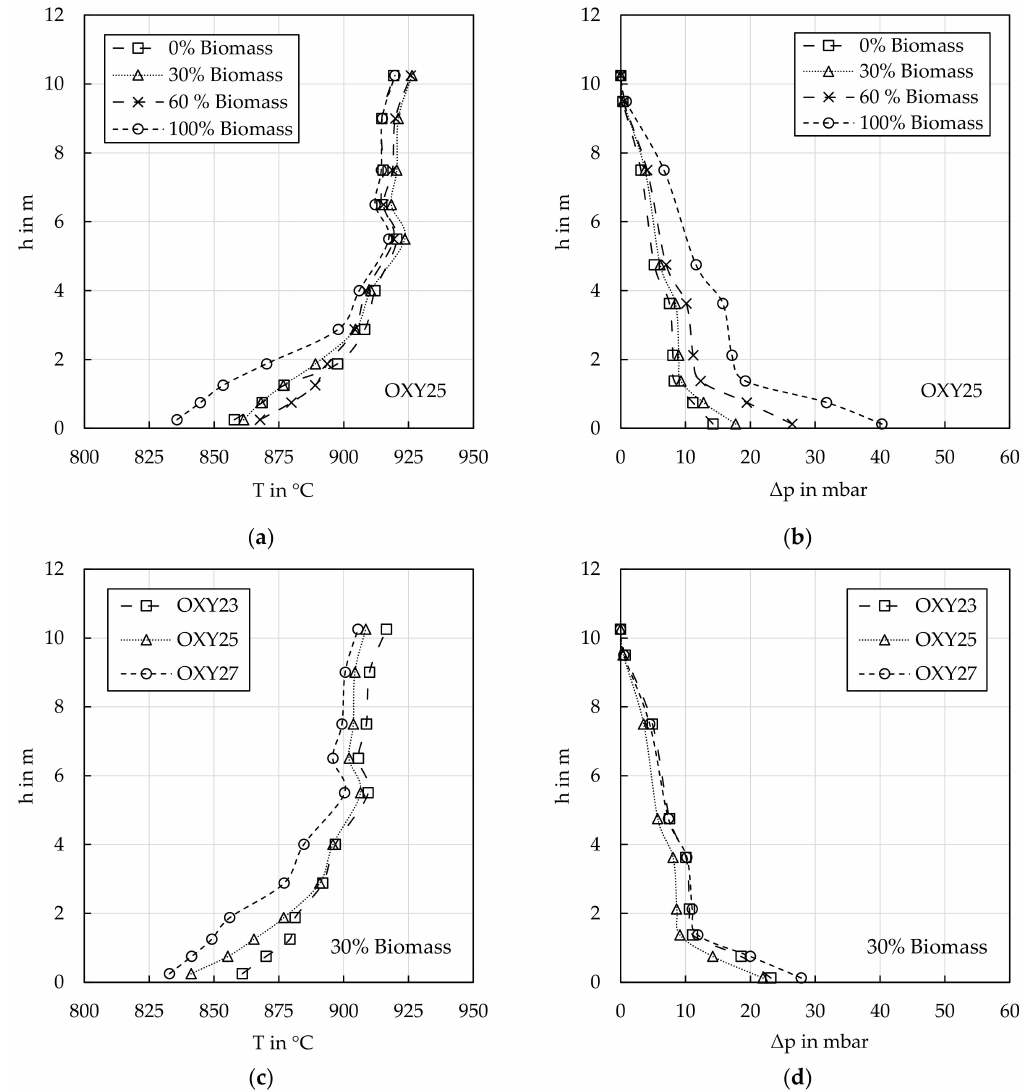
Figure 7. Calciner temperature ( a,c ) and pressure ( b,d ) profiles measured during the investigation of different fuel blending ratios and oxy-fuel